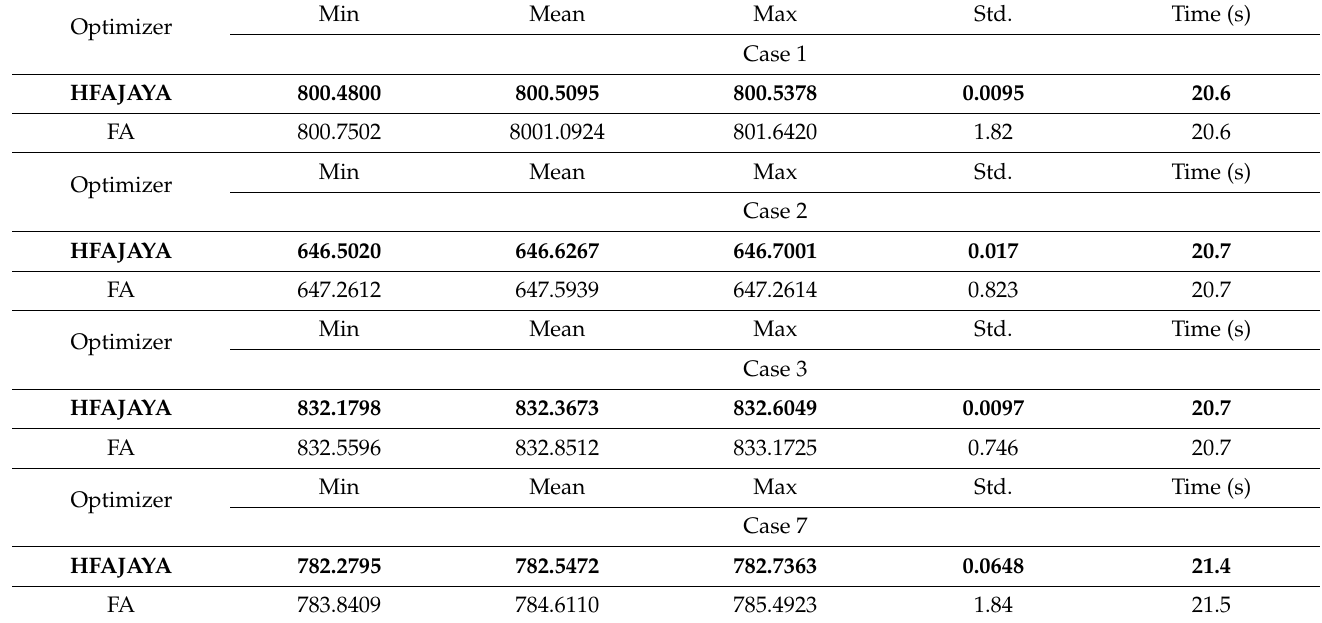
Table 12. Statistical results to show the performance of the proposed HFAJAYA and FA